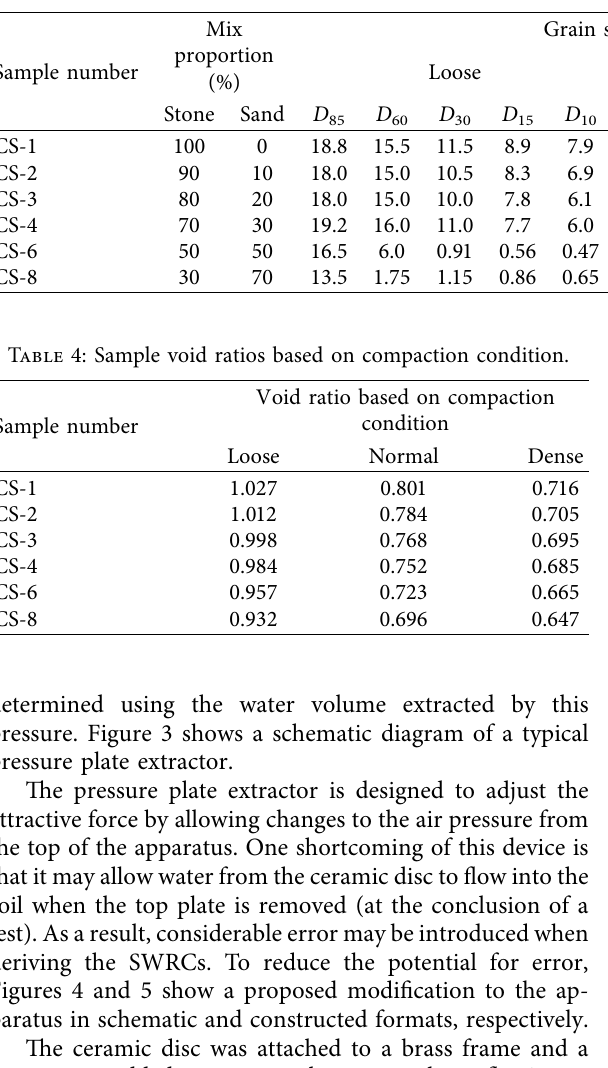
Table 3: Sample mix proportions and grain size based on compaction condition.